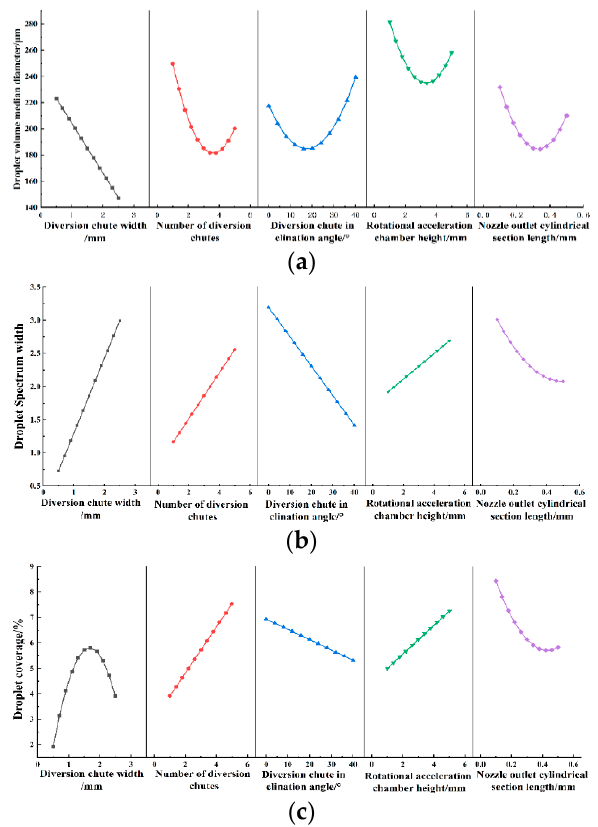
Figure 10. Main effect plot of spraying pesticide. ( a ) Influencing factors of droplet volume medium diameter, ( b ) influencing factors of droplet spectrum width, ( c ) influencing factors of droplet cover- age.